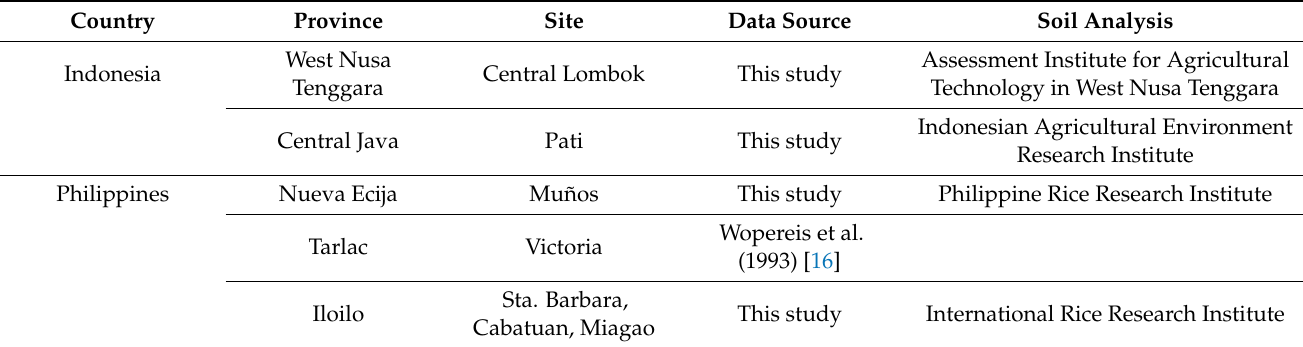
Table 4. Soil profile data preparation for different